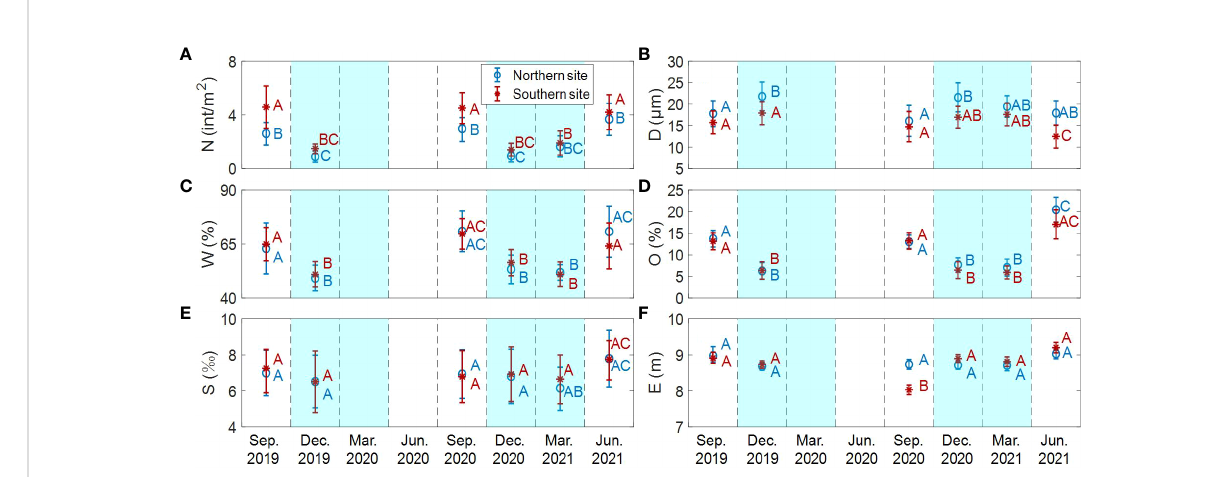
FIGURE 4 Variation of crab burrow distribution and environmental variables between the different sites in different seasons. (A) The density of crab burrows; (B) The median grain size; (C) The water content; (D) The organic matter content; (E) The soil salinity; (F) The elevation. Data is shown as means of the whole site ± SE. All ANOVA tests are signi fi cant (P<0.05 in each case). The white background showed the warm seasons. The blue background showed the cold seasons. Different letters denoted signi fi cant differences between treatments.